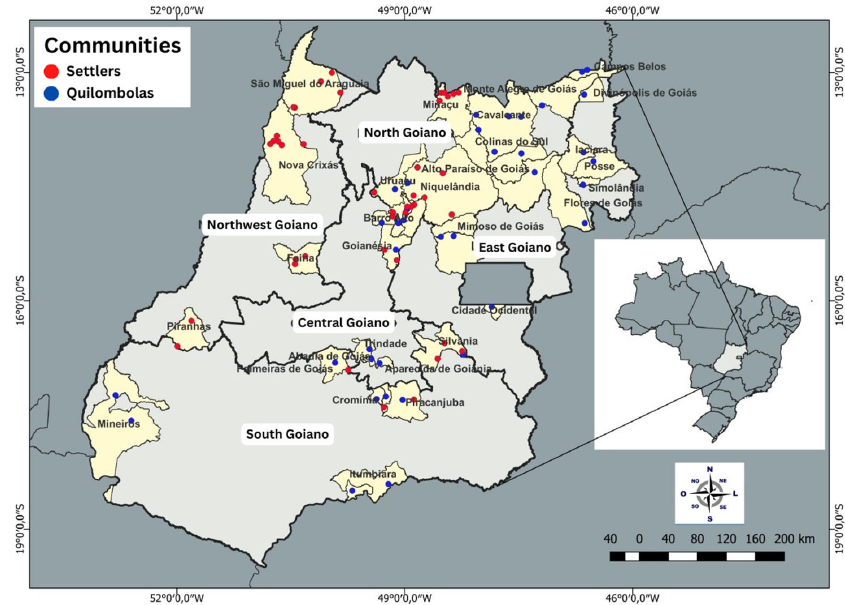
Figure 1. Distribution of communities and municipalities according to the mesoregions of the state of Goiás. Note: Map made using ArcGIS, version 3.24.3.